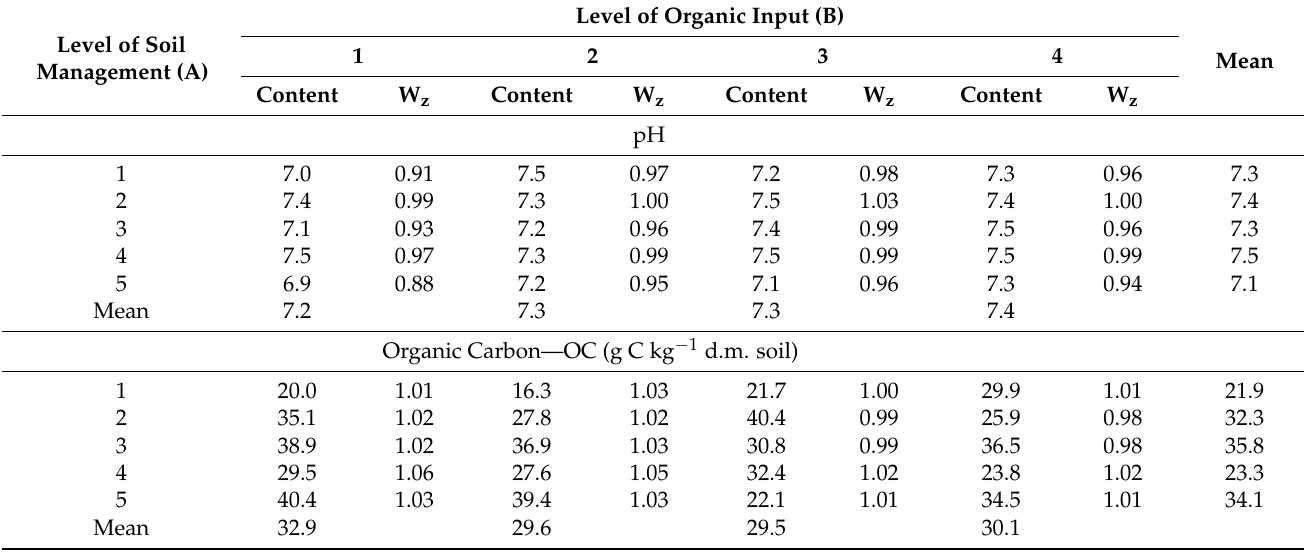
index mostly indicate a slight decrease in pH during the experiment (Table 5). Table 5. Chemical properties of soil depending on the method of tillage (factor A) and stubble management (factor B) in winter wheat